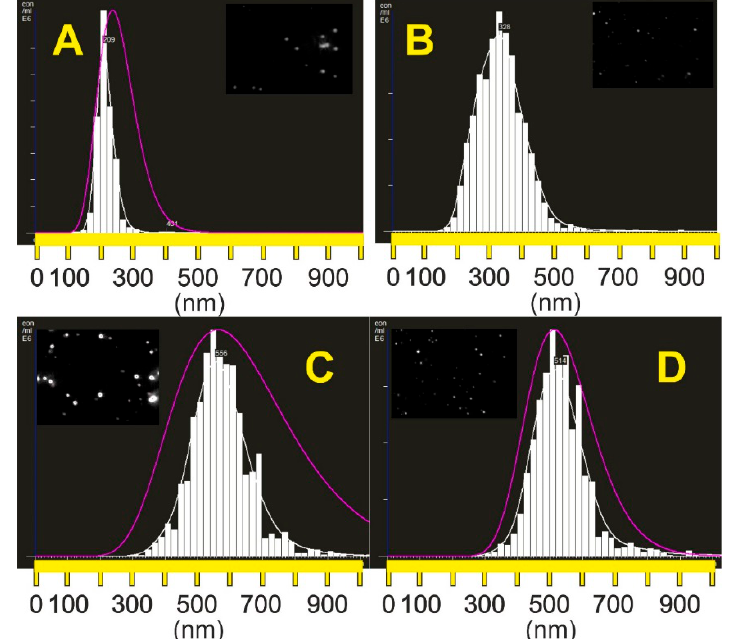
Figure 1. Particle size distribution of core H10 and H14 ( A , B ), core–shell H26 and H27 ( C , D ) particles obtained by NTA (pink curve—DLS Nanosight NS500 results; NTA video frames are shown in the inserts).